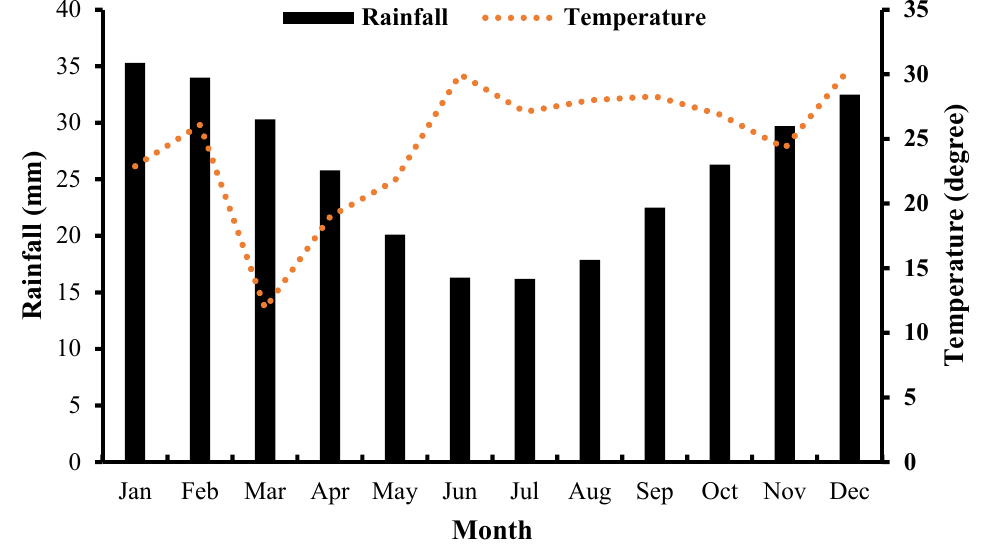
Figure 2. Modern climate of the study area. Monthly average temperature (Red dotes) and precipita- tion (black column) at Hawker Weather Station (1980–2021). Data source: The Australia Bureau of Meteorology, http://www.bom.gov.au/) (accessed on 12 July 2021).